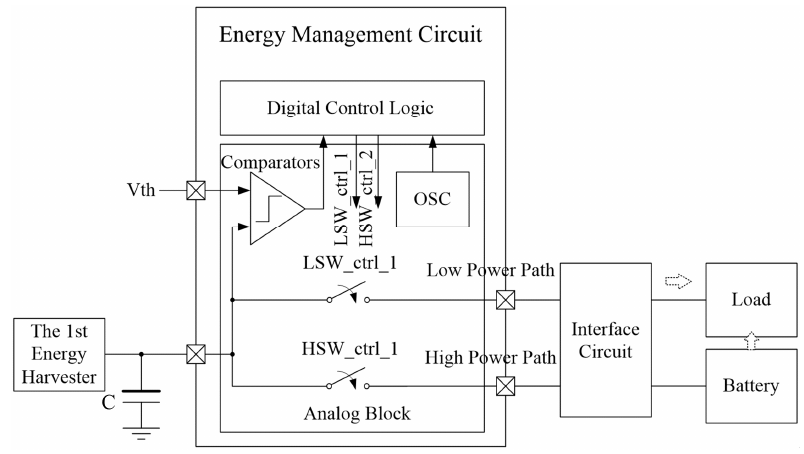
Figure 3. Architecture for a single-source energy harvester with the proposed energy management circuit.